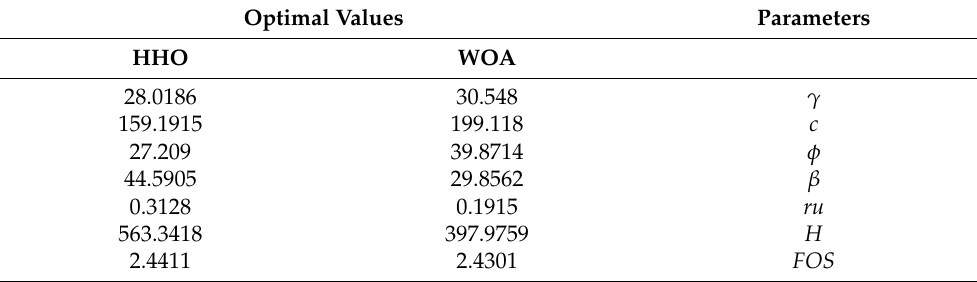
Table 7. Optimal parameters of FOS based on WOA and